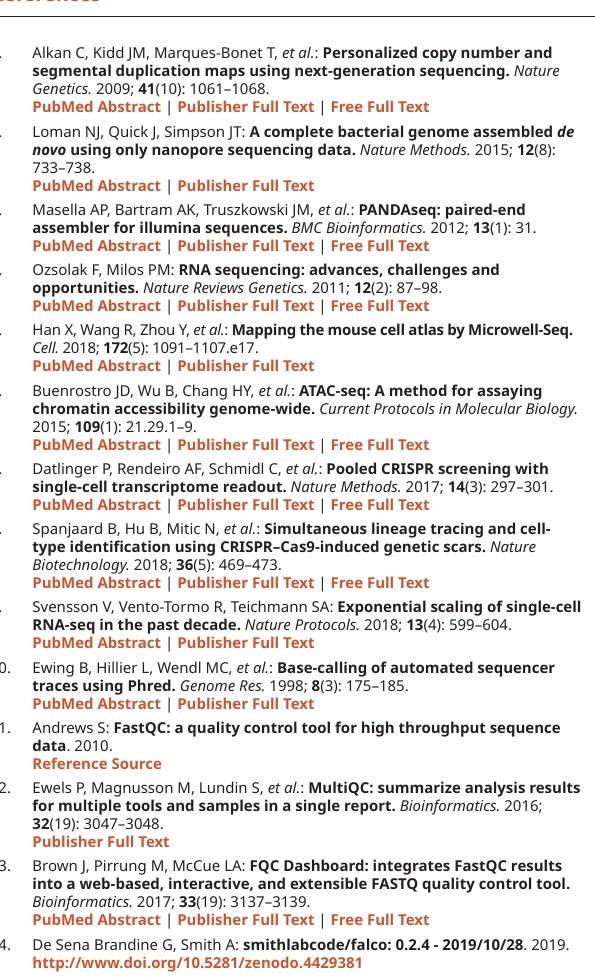
Table 2. Guidance for how to accept accession wgs-FAB49164 is available from the Benchmark directory of the GitHub